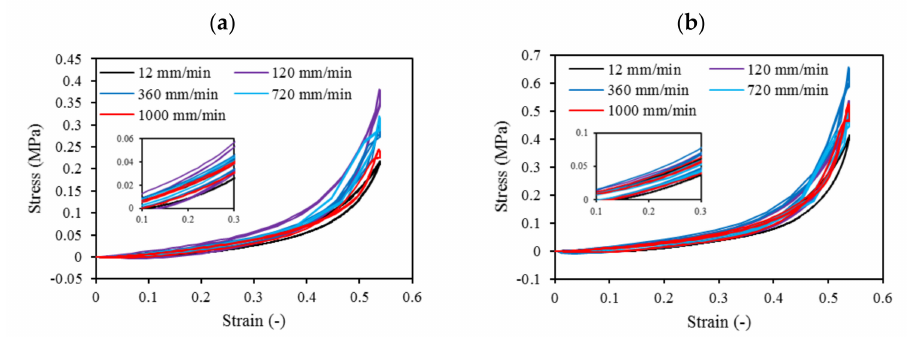
Figure 12. Four-cycle cyclic stress-strain for ( a ) STD-Eco30 and ( b ) STD-Eco50 at strain rates of 12, 120, 360, 720, and 1000 mm /